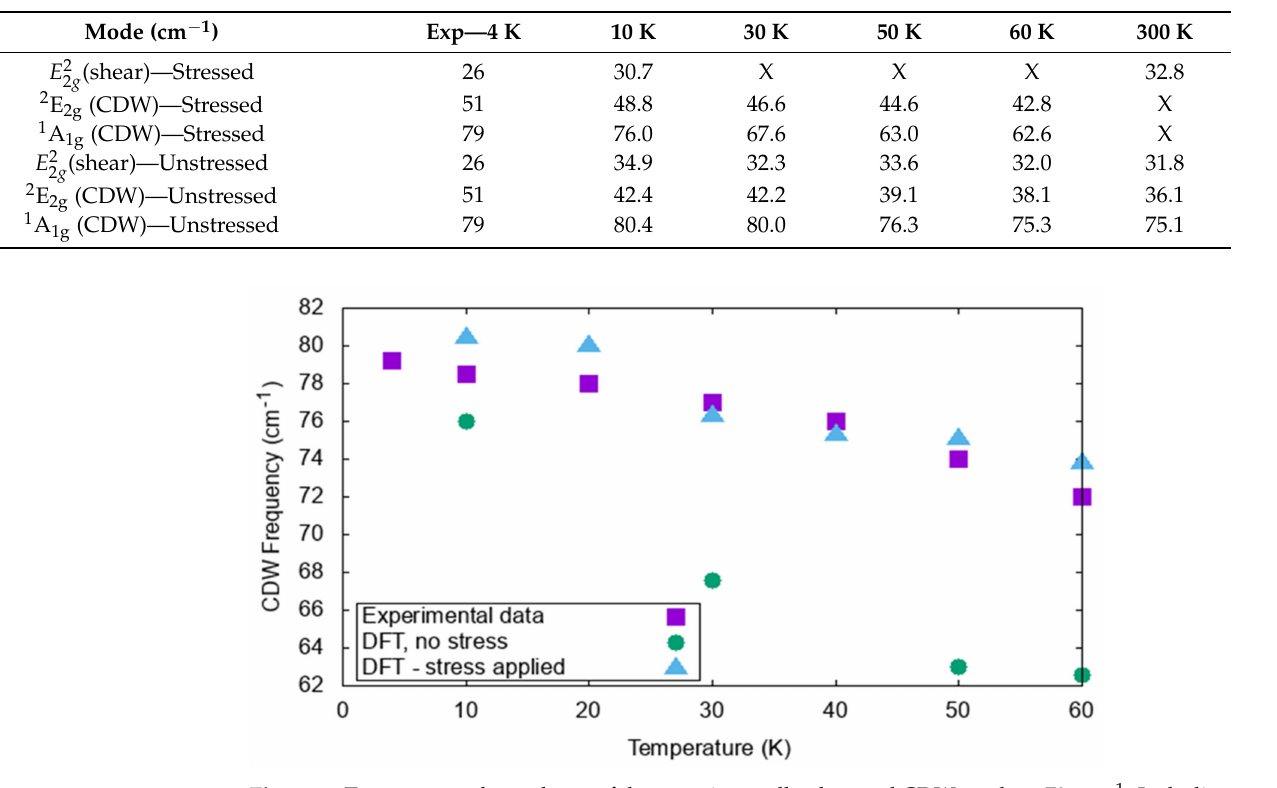
Figure 5. Temperature dependence of the experimentally observed CDW mode at 79 cm − 1 . Including incommensurability through a small compression in the simulation cell (triangular data) leads to an excellent reproduction of the experimental data.